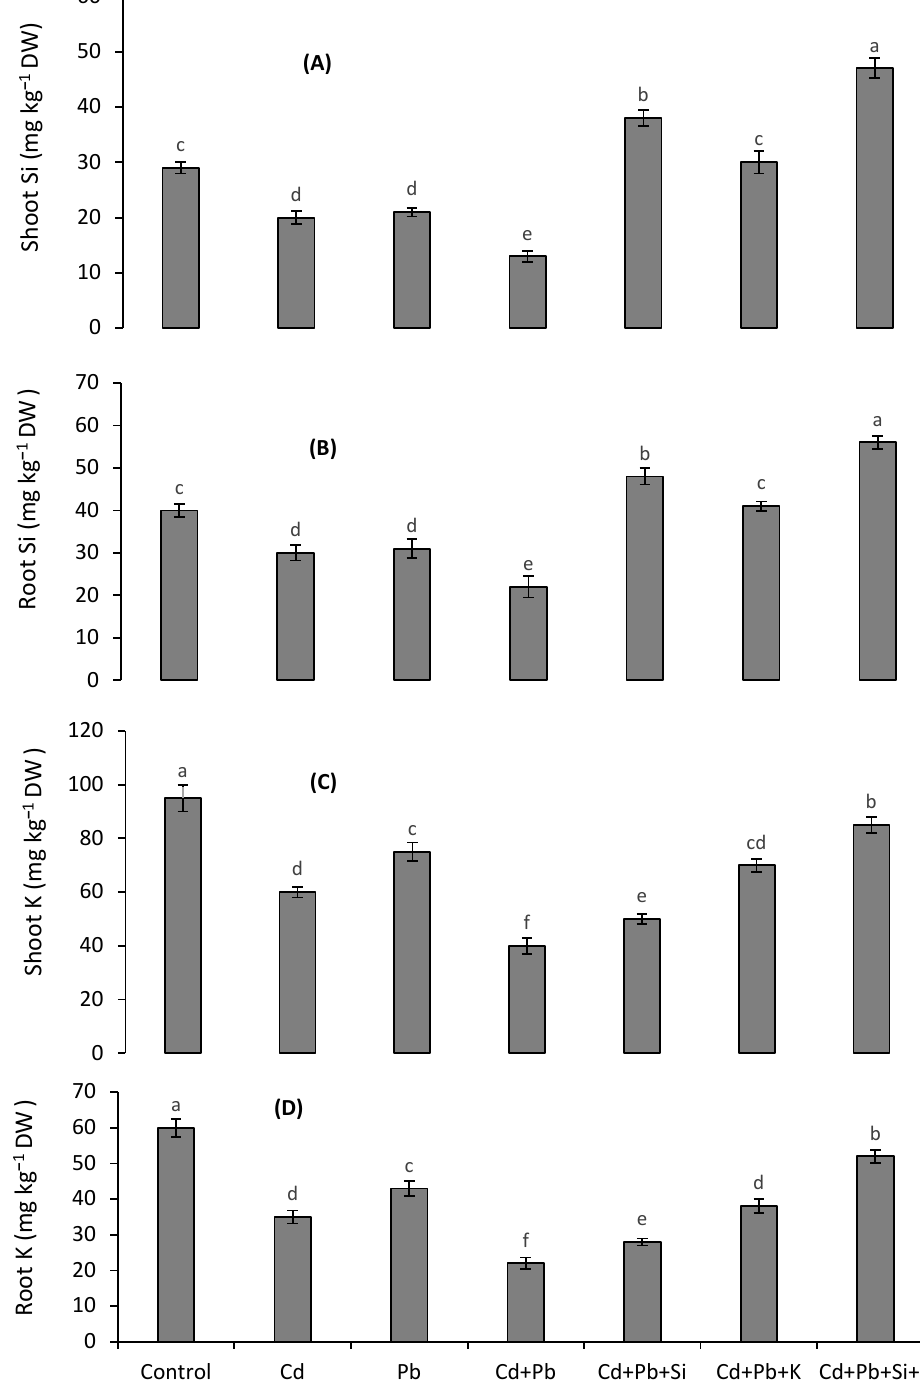
Figure 3. Effect of different Cd and Pb treatments on shoot Si ( A ), root Si ( B ) shoot K ( C ) and root K ( D ) concentrations in quinoa with and without supplementation with Si and K. Bars with different letters indicate the significant difference among the treatments at 5% significance level .